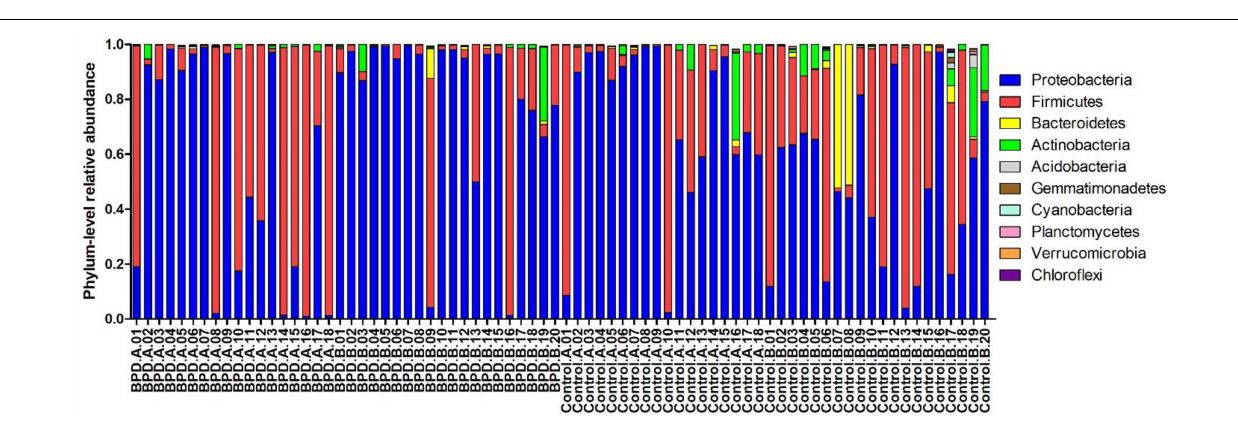
increased significantly from days 3–7 to days 14–28 (53.9